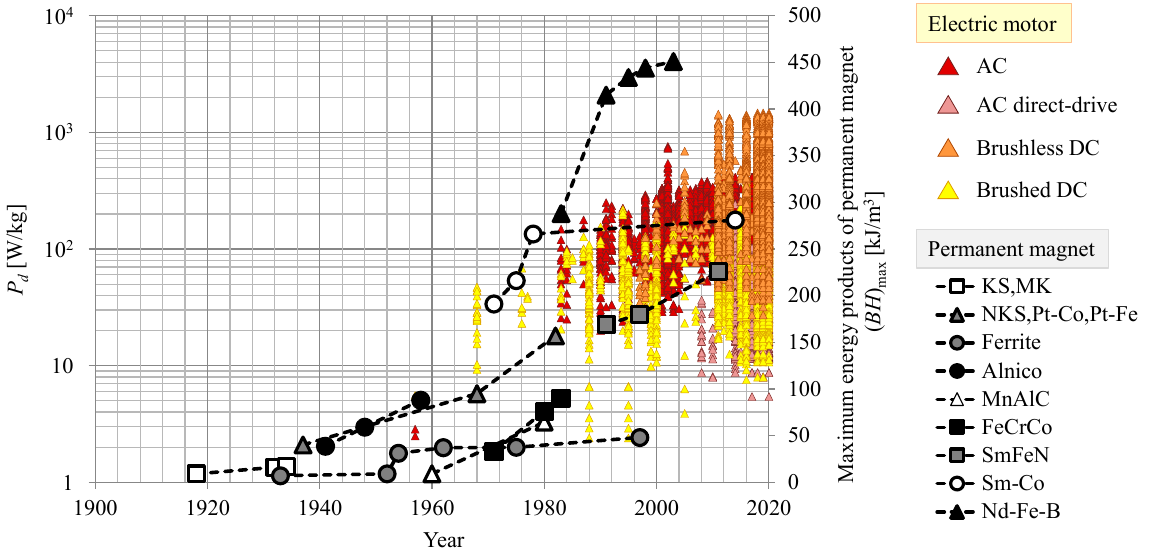
Figure 2. Transition of power density in electric motors and maximum energy products of perma- nent magnets.